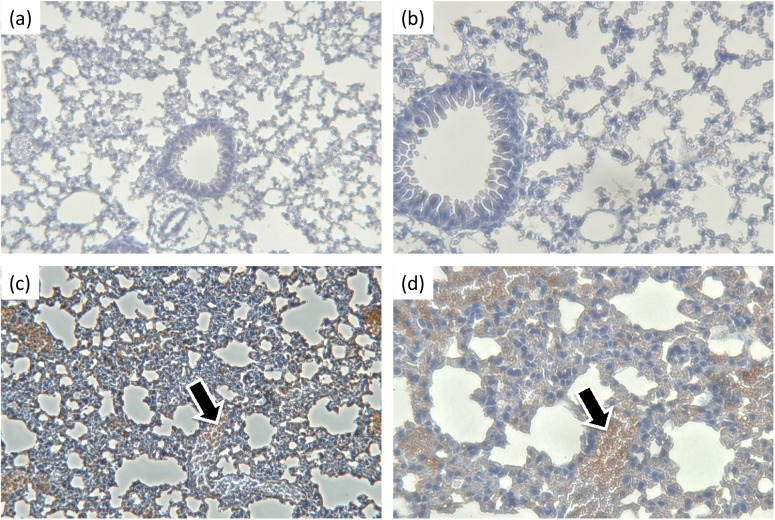
Biodistribution of plasmids in the lungs by intratracheal delivery.The intratracheal model was performed by administering the plasmids through a 2.5-mm human otoscope specula that was placed directly into the trachea via the mouth. Forty-eight hours after plasmid delivery, GFP proteins were observed in lung sections by immunohistochemistry (IHC) staining (black arrows). Negative controls at (a) 200X and (b) 400X with IHC staining and (c) 200X and (d) 400X.